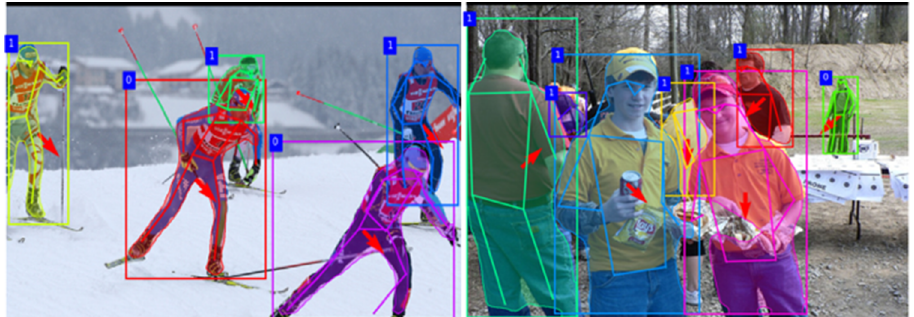
Table 4. Accuracy of orientation recognition when a neighbor error allowed (%). Figure 16. Examples of the results for orientation recognition. Figure 16. Examples of the results for orientation